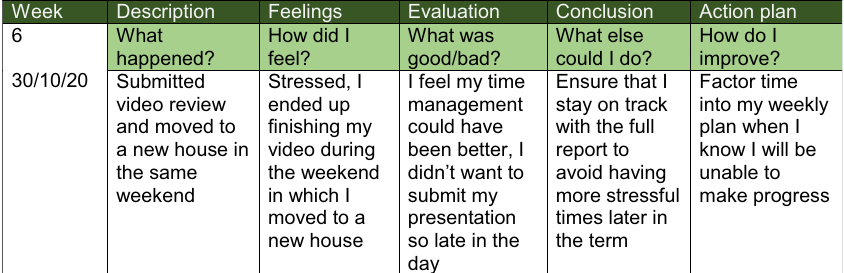
Figure 1. Reflective